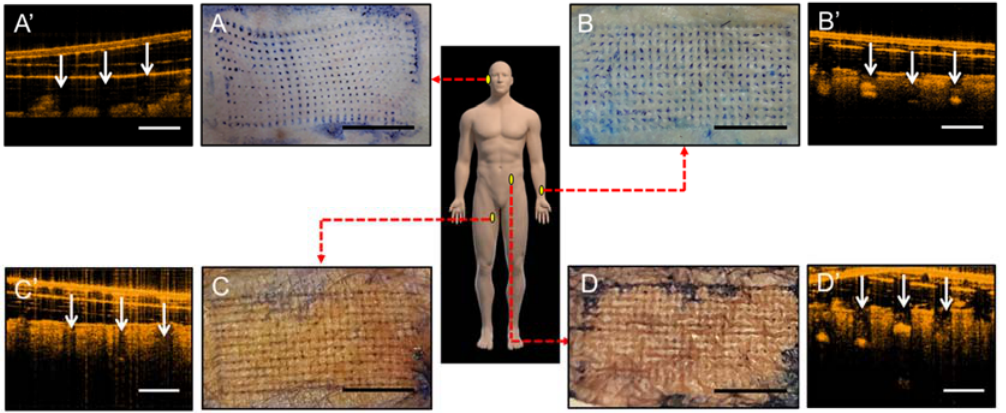
Figure 6. In vitro insertion capability of patches of gelatin/CMC MNs applied to discarded human skins from various locations which were then stained with blue tissue-marking dye after patches removal. ( A ) Dorsal ear skin. ( B ) Ventral forearm skin. ( C ) Medial thigh skin. ( D ) Abdominal wall skin. Scale bar = 5 mm. ( A ’– D ’) Respective OCT images of human cadaveric skin after MNs insertion. White arrows indicate the location of micro-disruption in the dermis. Scale bar = 500 μ m.